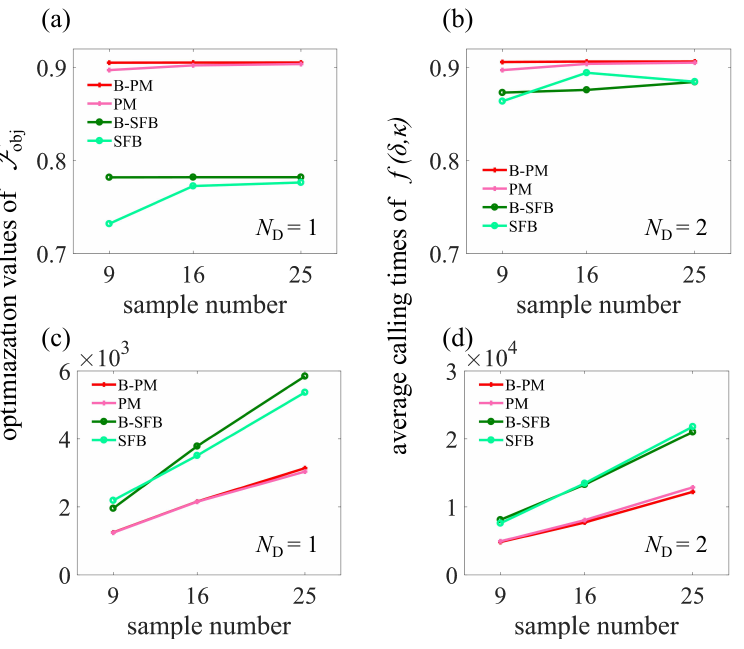
Figure 5. ( a ) Optimizedfidelity of B-PM, PM, B-SFB and SFB methods with parameter set number N D = 1. ( b ) Optimized fidelity of B-PM, PM, B-SFB and SFB methods with parameter set number N D = 2. ( c , d ) Average function f ( δ , κ ) calling times in Equation (6) that gave the results in ( a , b ), respectively. All results are based on 100 trials with random initial parameters. The total evolution time was taken as T = 100 ns, and the maximal field amplitude was bounded as max | g ( t ) | (cid:54) Ω max = 2 π × 10